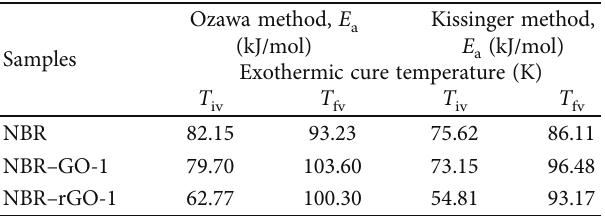
Table 4: The E (kJ/mol) of the un-activated sulfur cured systems a by DSC.